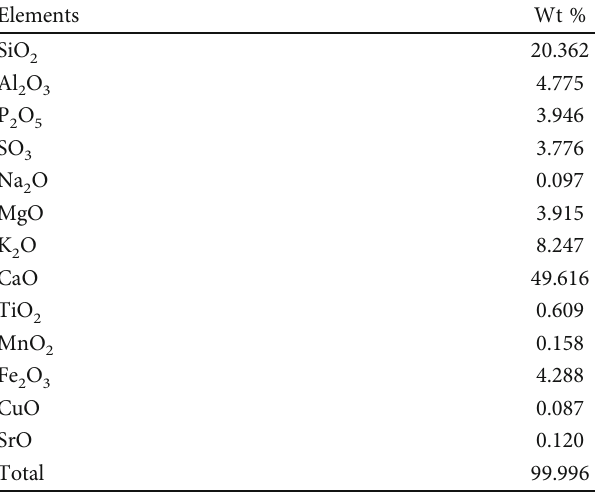
Table 2: Major elemental oxides present in the ISA analyzed by X- ray fl uorescence adopted from